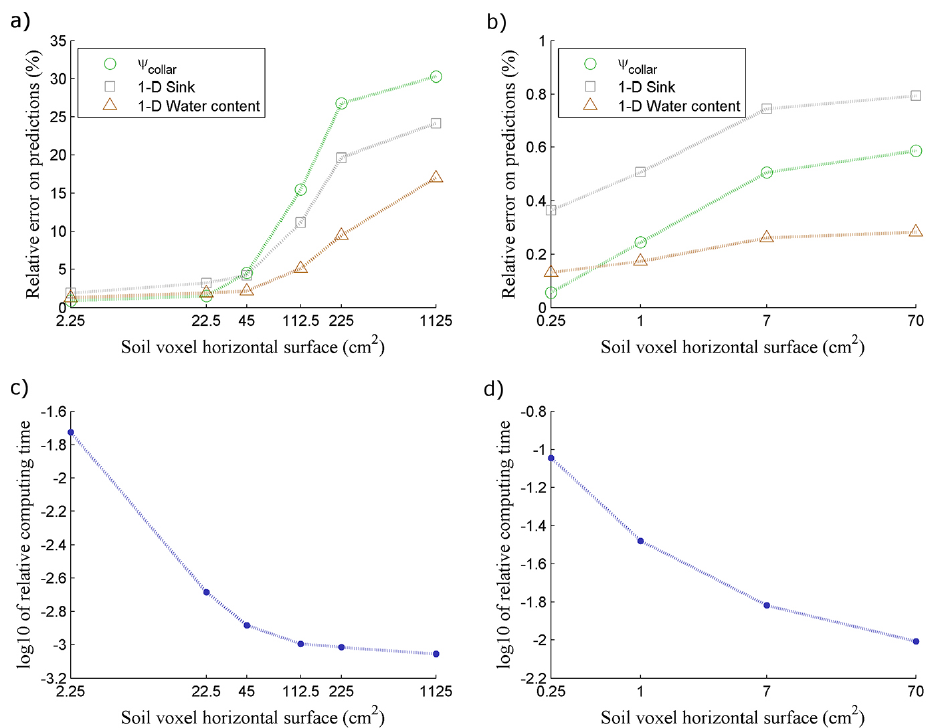
Fig. 5. Relative errors on three state variable predictions ( ψ collar , 1-D sink and 1-D water content) when using upscaled soil elements whose inner SWP is considered as homogeneous, for maize (a) and winter wheat (b) . Relative computing time for maize (c) and wheat (d) . x axes on logarithmic scale. Scenario: high T daily on silt